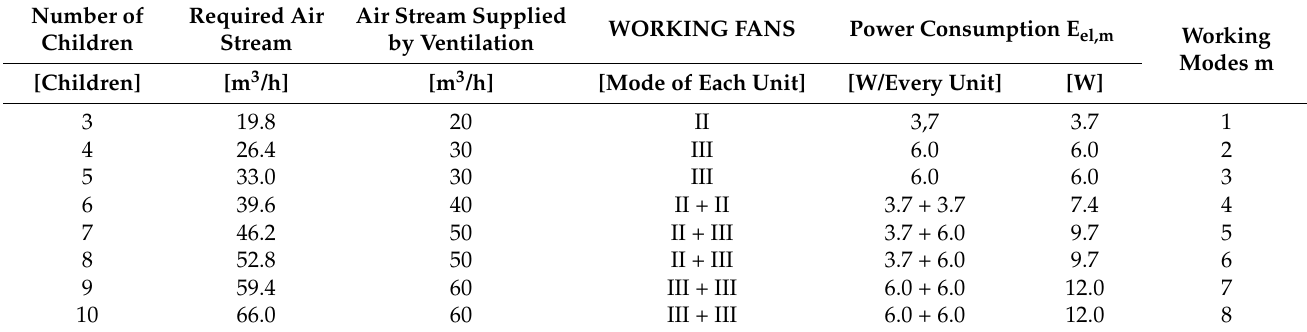
Table 4. Working modes of fans in relations to the number of